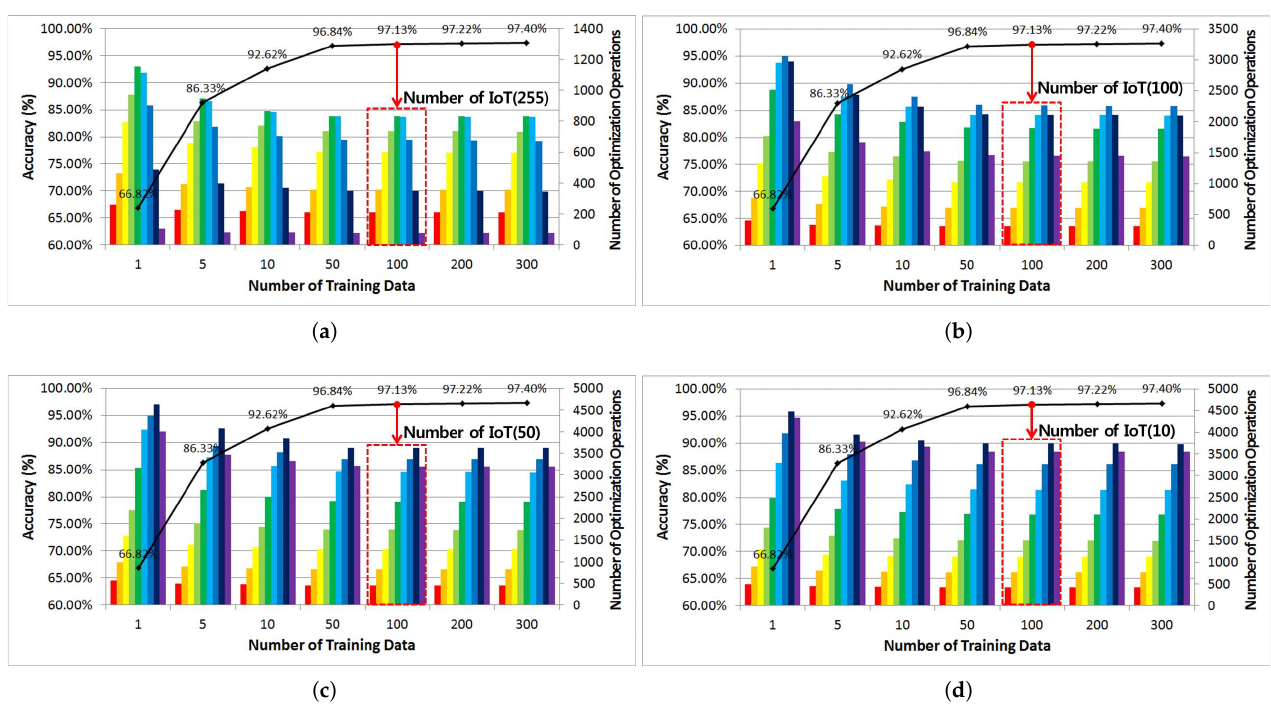
Figure 18. Comparison and analysis of the number of optimization engine operations according to the prediction accuracy for the number of IoT devices. ( a ) Number of IoT: 255, ( b ) Number of IoT: 100, ( c ) Number of IoT: 50, ( d ) Number of IoT: